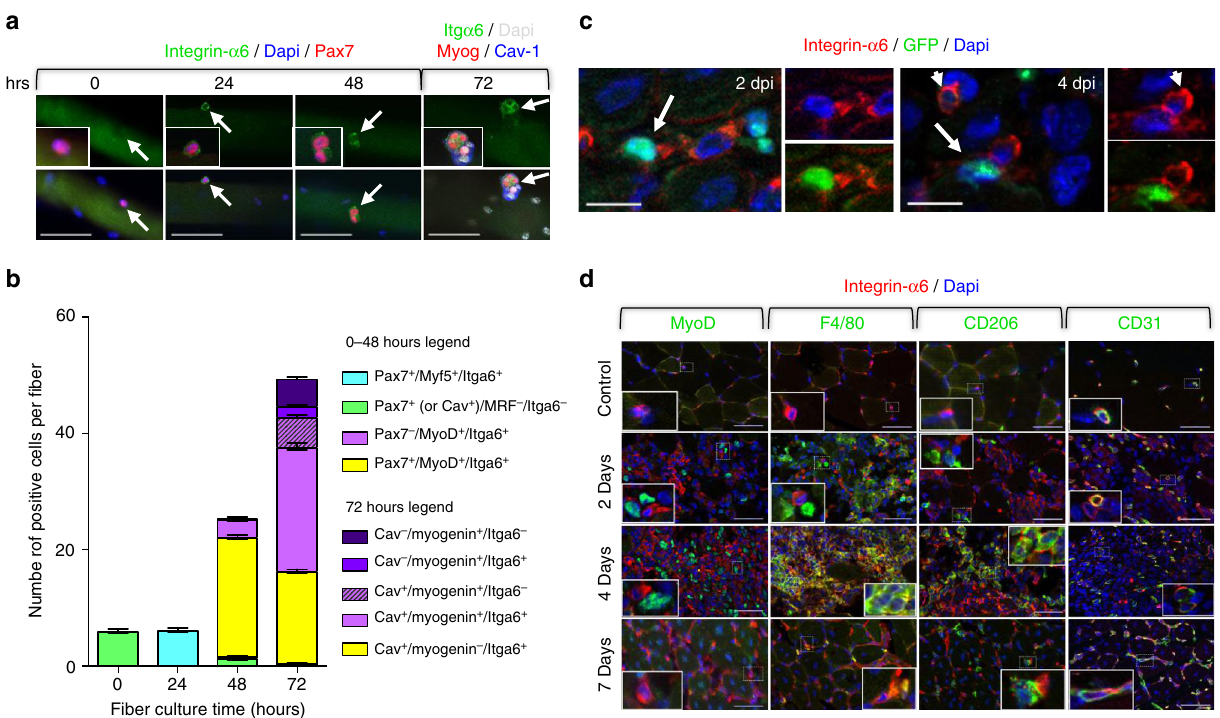
Fig. 6 Integrin- α 6 mediates laminin- α 1 control of SC expansion. a Immuno fl uorescence analysis of cultured EDL myo fi bers showing integrin- α 6 upregulation in activated SCs. Inserts show high magni fi cation images of satellite cells indicated by the white arrows. Top panels show images in the green channel only, bottom panels show the merge images, inserts are higher magni fi cation of merge image. Scale bar, 50 μ m. b Quanti fi cation of integrin- α 6 expression in satellite cells from cultured myo fi bers. n = 3 with 20 – 30 fi bers per time point. c Integrin- α 6 (red) distribution in 2 dpi and 4 dpi injured TA muscle of Tg(Pax7-GFP) mice. Images of the blue/red channels and green/red channels show colocalization of integrin- α 6 with satellite cells (white arrows) and with predicted endothelial cells (white arrowheads). Scale bar, 20 μ m. d Immuno-colocalization of integrin- α 6 (red) with either MyoD